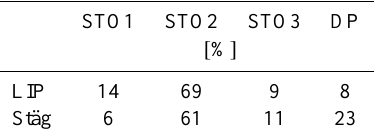
Table 2. Areal percentage of each dominant runoff process (DoRP) in the Lippenrütibach catchment and the Stägbach catchment [%] – relative to the total agricultural area. STO1 – low storage capacity, STO2 – intermediate storage capacity, STO3 – high storage capac- ity, DP – deep drainage.